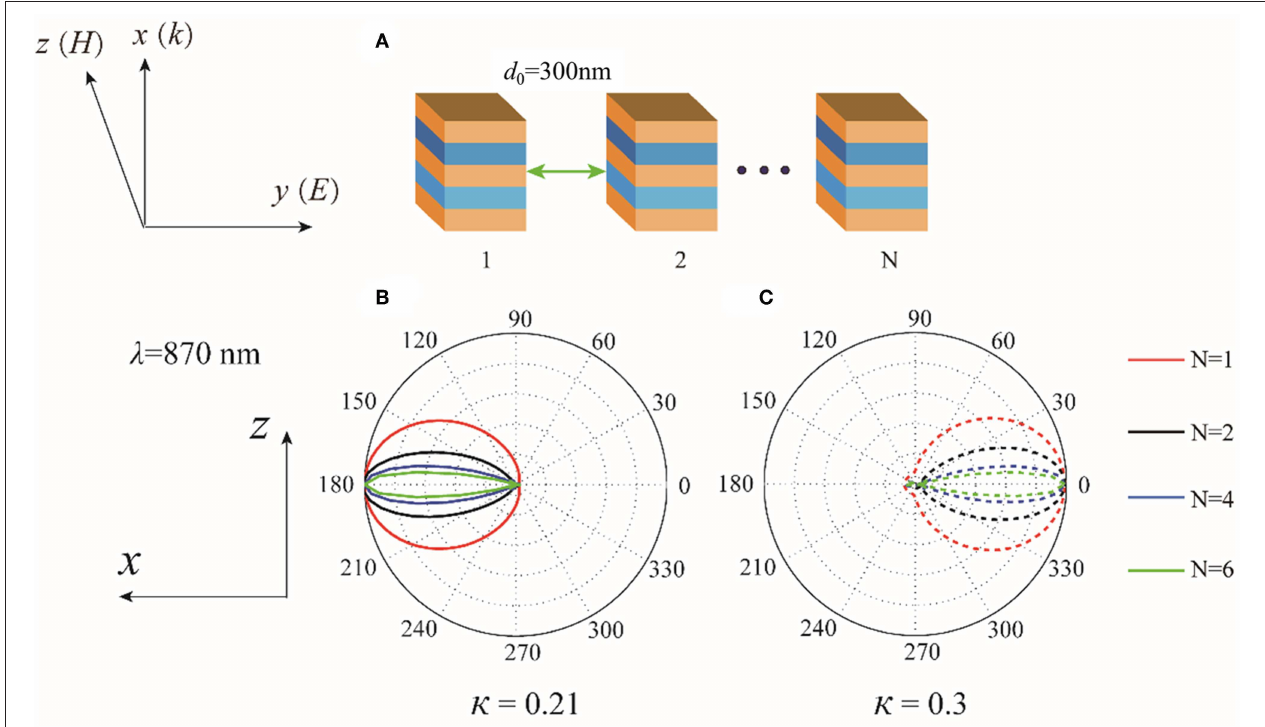
FIGURE 7 | (A) Chain of the PT -symmetric structure with inter-particle distance d . (B,C) Scattering patterns in xoz plane by a chain such particles with N = 1,2,4, and 6 for κ = 0.21 and κ = 0.3 at λ = 870nm, respectively.